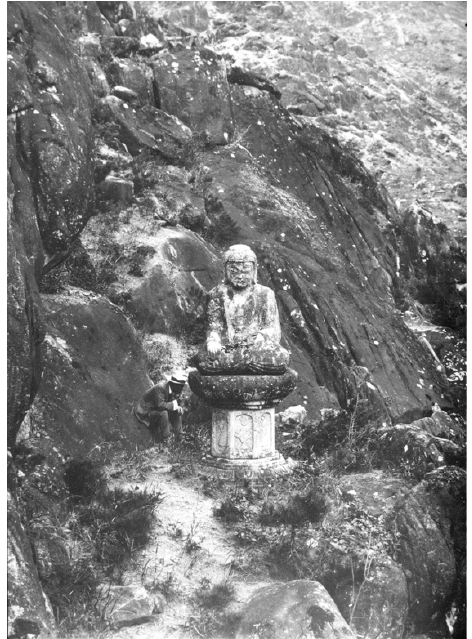
Figure 1. Seated Buddha. Samn ŭ nggye valley on Mount Nam. 8–9th century, Unified Silla. Gelatin dry plate from the colonial period. Courtesy of National Museum of Korea.